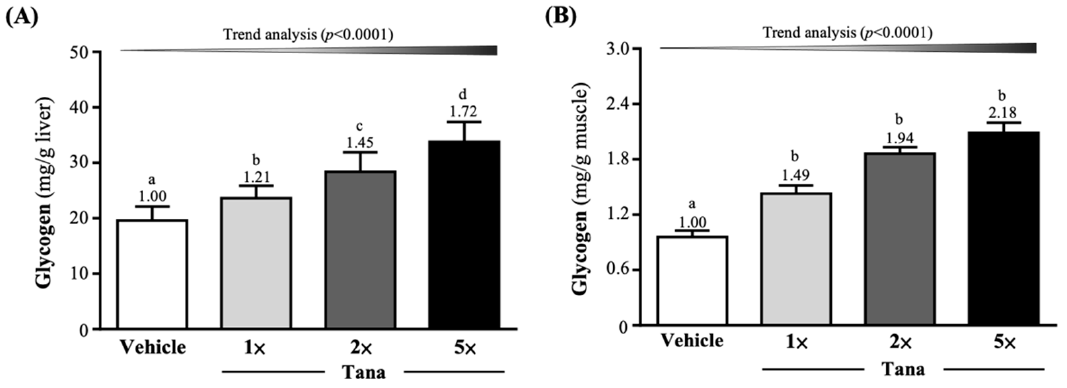
Figure 4. Effect of supplementation with Tana on ( A ) liver and ( B ) muscle. Data are expressed as mean ± SD for n = 10 mice per group. The different superscript letters (a, b, c, d) above each bar indicate a significant difference at p < 0.05.